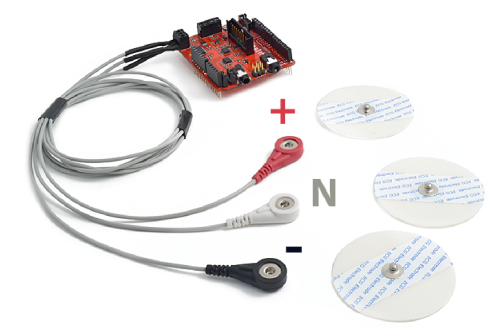
Figure 2. ECG electrode connected to e-Health sensor shield.